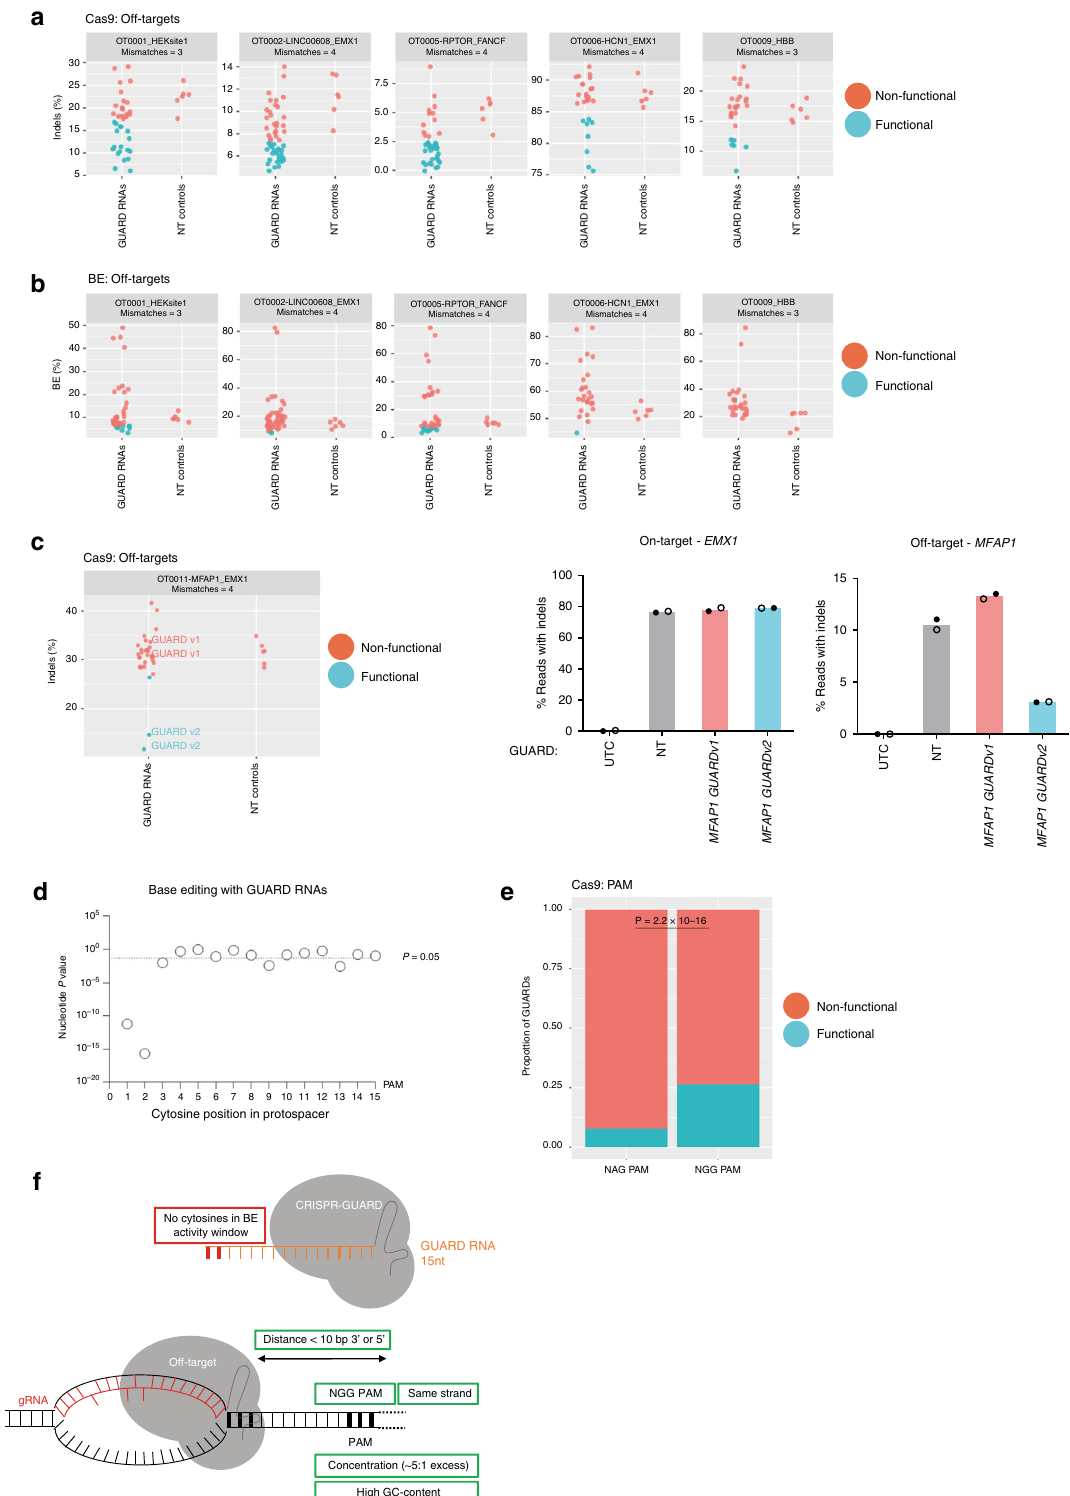
Bio-layer interferometry (BLI) . DNA substrate was generated from duplexing a biotin-conjugated oligo with an unlabelled oligo coding for the CAVIN4 off-target site of the VEGFA gRNA. Labelled strand (AGCCACAACCCTGTTGGACGTCC TGAGGCGGGGTGGGGGGGTGTGCAAGGGAACTCTCC), unlabelled strand (GGAGAGTTCCCTTGCACACCCCCCCACCCCGCCTCAGGACGTCCAACAG GGTTGTGGCT). GUARD RNA (CCCCCACCCCGCCTC), gRNA (GACCCCC TCCACCCCGCCTC). BLI measurements were performed at 25 °C using an Octet Red96 instrument (ForteBio). The measurement buffer consisted of